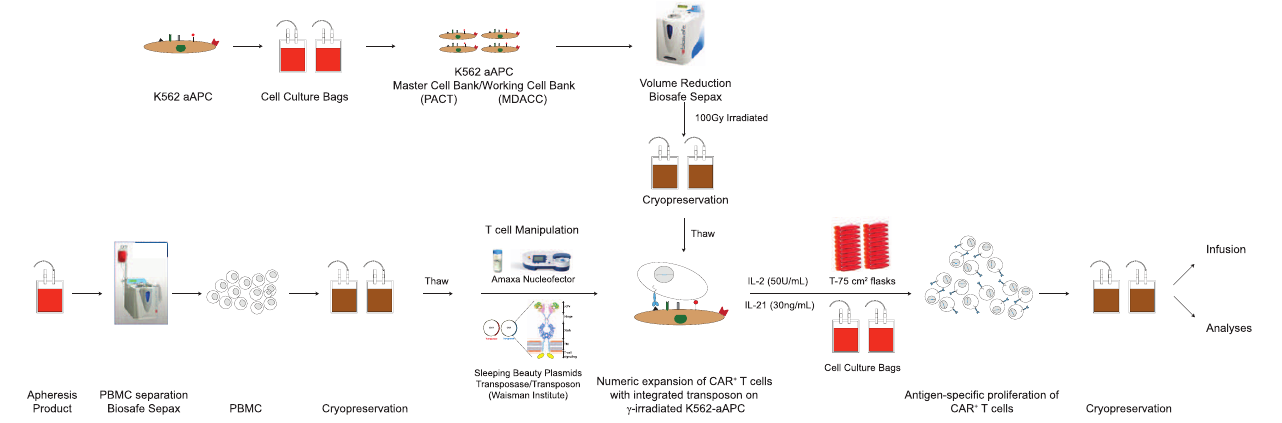
Figure 2. Schematic of the process of generating clinical grade CD19-specific T cells. A MCB (PACT) and WCB (MDACC) were generated for K562-derived aAPC (clone # 4). For the generation of CAR + T cells, aAPC were numerically expanded in bags, harvested using the Sepax II system, irradiated (100 Gy), and cryopreserved for later use. CD19-specific T cells were manufactured as follows; PBMC were isolated from normal donor apheresis products using the Sepax II system and cryopreserved. The PBMC were later thawed, electroporated with the SB DNA plasmids (CD19RCD28 CAR transposon, SB11 transposase) using the Nucleofector System, co-cultured with thawed irradiated aAPC along with cytokines (IL-2 and IL-21) for a culture period of 28 days and cryopreserved.